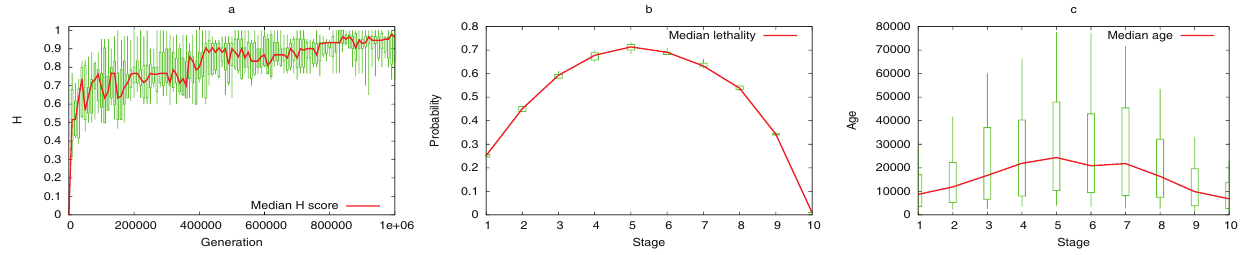
Figure 8. Computational results with Model-4. Parameters: 10 runs with different initial populations, N = 10 individuals, L = 10 stages, specificity function s ( l ) = l / L ( l = 1 . . . L − 1), Γ = 100 genes at each stage initially, RF parameter z = 4, 1,000,000 generations, probability of RW event P = 10 −4 . The probability of gene duplication P is adjusted dynamically so that the average DGEN size stays between 700 and RW DP 800 genes. The probability of gene deletion (DL) is P = 10 −6 . The red line is the median and the green boxes are the 10th, 25th, 75th, and DL 90th percentiles, across all individuals and all runs. ( a ) The hourglass score H across evolutionary time. ( b ) Lethality probability at each stage. ( c ) Age of existing genes at the last generation.